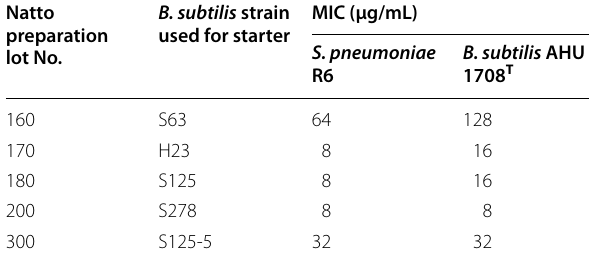
Table 1 MICs of the Natto-peptide tested against various Gram-positive bacteria, Gram-negative bacteria, and fungi